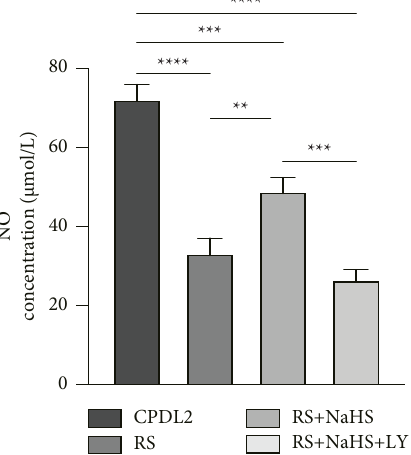
Figure 8: Efect of NaHS pre-treatment on NO concentration in HUVECs. Intracellular NO production was assessed using the nitric oxide fuorometric assay kit and the efects of NaHS on NO concentration in the indicated groups were compared in each group. n � 3 per group. ∗ P < 0 . 05, ∗∗ P < 0 . 01 by LSD-t test after ANOVA. CON: control group, HUVECs at CPDL2; RS: replicative senescence group, HUVECs at CPDL16; RS +NaHS: HUVECs at CPDL16 and exposed to 200 μ mol/L NaHS for 24hours. RS +NaHS+LY:HUVECs at CPDL16 and exposed to 10 μ mol/L LY294002 prior to treatment of 200 μ mol/L NaHS for